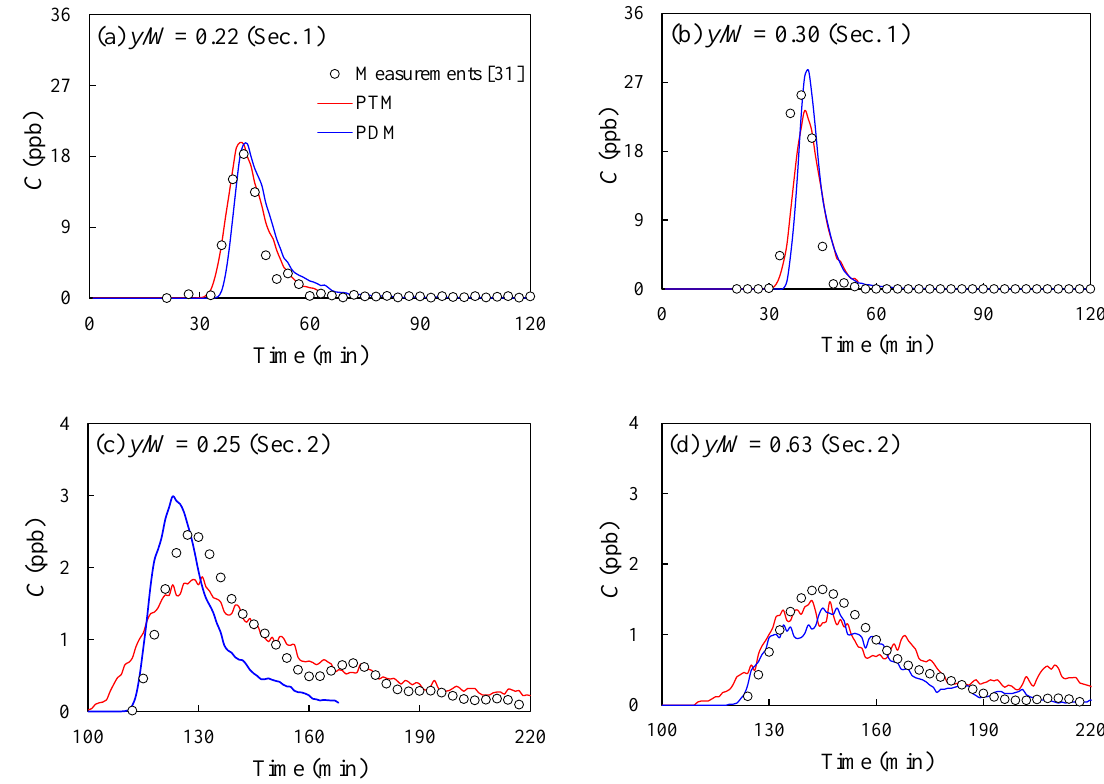
Figure 11. Comparisons of temporal concentration variations in the Hongcheon River. Table 5. Statistical properties of concentration curves in the Hongcheon